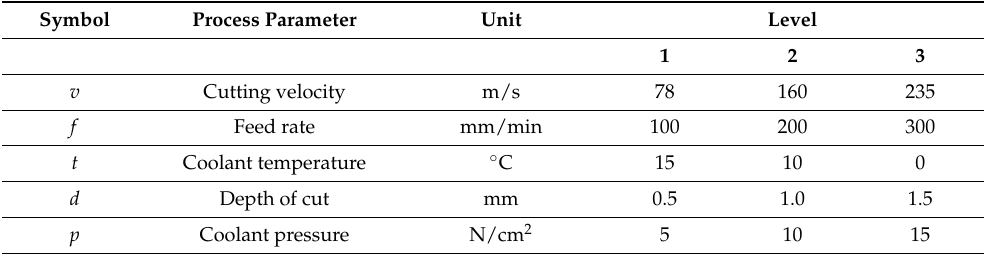
Table 2. Important factors considered for experimentations.